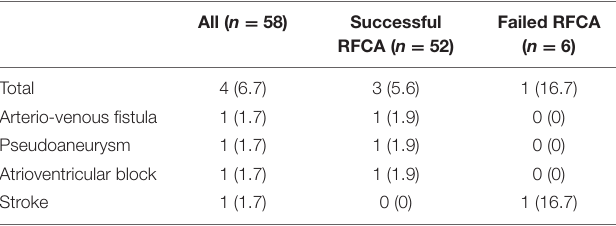
TABLE 4 | Complications associated with the ablation procedure. All ( n =